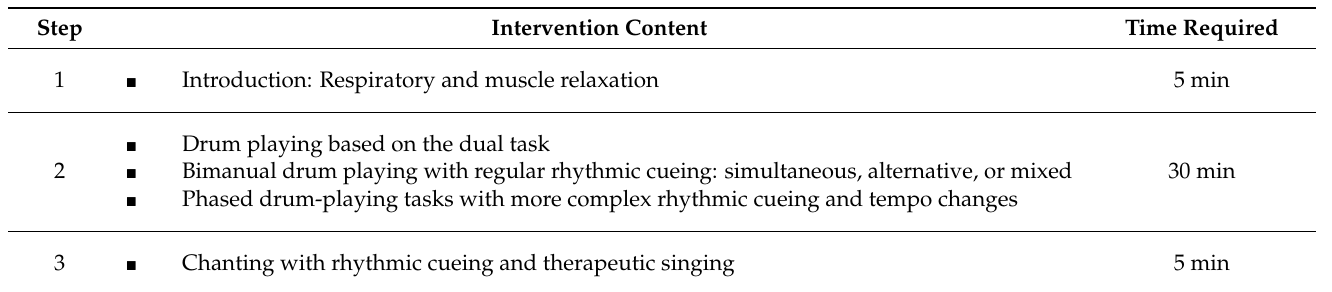
Table 2. The steps of the dual-task-based drum-playing intervention.